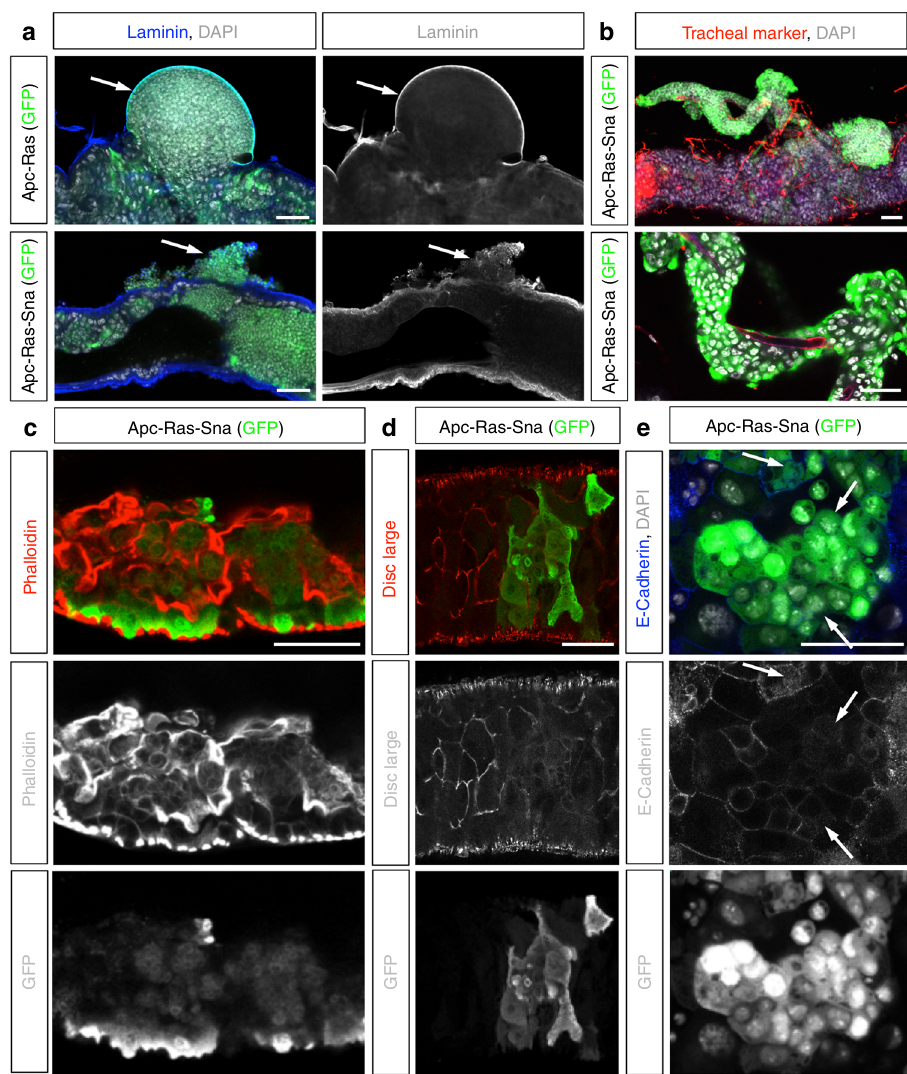
Fig. 3 Snail induces a partial epithelial-to-mesenchymal transition and collective migration. a Apc-Ras (top) and Apc-Ras-Sna (bottom) primary tumors (GFP, Green) and basal lamina (Laminin, blue). APC-Ras primary tumors never break through the basal lamina of the midgut (top, arrow). In midguts bearing Apc-Ras-Sna tumors, the basal lamina is highly disrupted and shows large breaks, with GFP + cells found outside the midgut near where the basal lamina has been disrupted (bottom, arrow). b A primary tumor (GFP, green) extending out from the midgut and enveloping surrounding tracheal tubes (tracheal marker — chitin-binding protein, red). Nuclei are stained with DAPI (white). c – e Apc-Ras-Sna primary tumors stained for GFP (green) and F-Actin ( c , phalloidin, red); discs large ( d , red) and E-Cadherin ( e , blue). Arrows in e point to intracellular punctae of E-Cadherin. Scale bars = 50 µ m